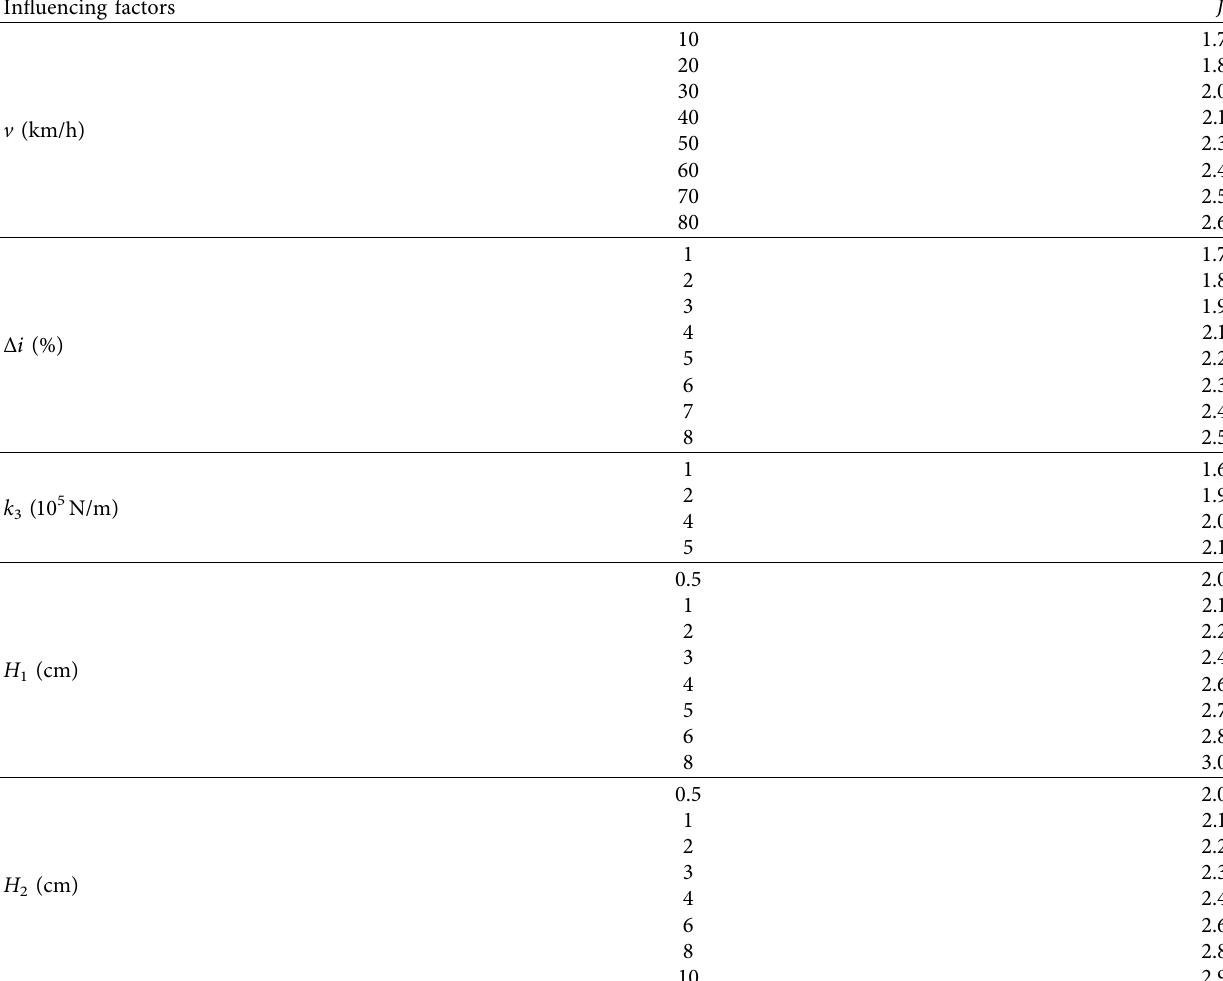
Figure 5: Time history curves for impact load coefficients ( f ) under different influencing factors. (a) Factor of v . (b) Factor of H of H 2 . (d) Factor of k 4 . (e) Factor of Δ i . (f) Factor of c 3 . (g) Factor of k 3 . Table 4: Pavement damage coefficients ( J ) under different influencing